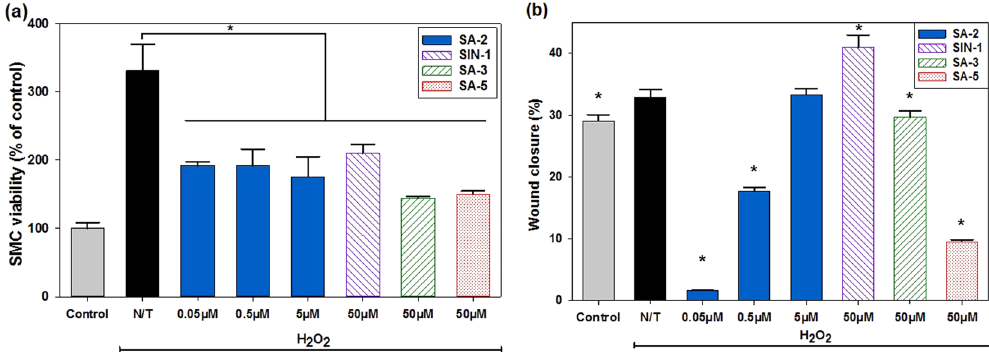
Figure 5. Effects of SA-2 on the SMC viability ( a ) and migration ( b ) under oxidative stress conditions. Cells were seeded and allowed to attach on tissue culture plates. For the migration study, micropipette tips were used to make scratch lines on wells, followed by washing with PBS and imaging for initial gap distances. Compound SA-2 at different concentrations, SIN-1 (50 µ M), SA-3 (50 µ M), or SA-5 (50 µ M) was added to cell samples, stressed with H 2 O 2 and incubated for 24 hours. Controls were cells not exposed to H 2 O 2 or any treatment reagent. N/T samples were cells exposed to H 2 O 2 without any test compound. Cell viability was quantified with MTS assays while cell migration was imaged and analyzed for final gap distances via ImageJ. Results were then processed on SigmaPlot for statistical analysis using ANOVA followed by post hoc comparisons. Results are presented as mean values ± SEM. Stars indicate significant differences (P < 0.05; n = 4) with respect to